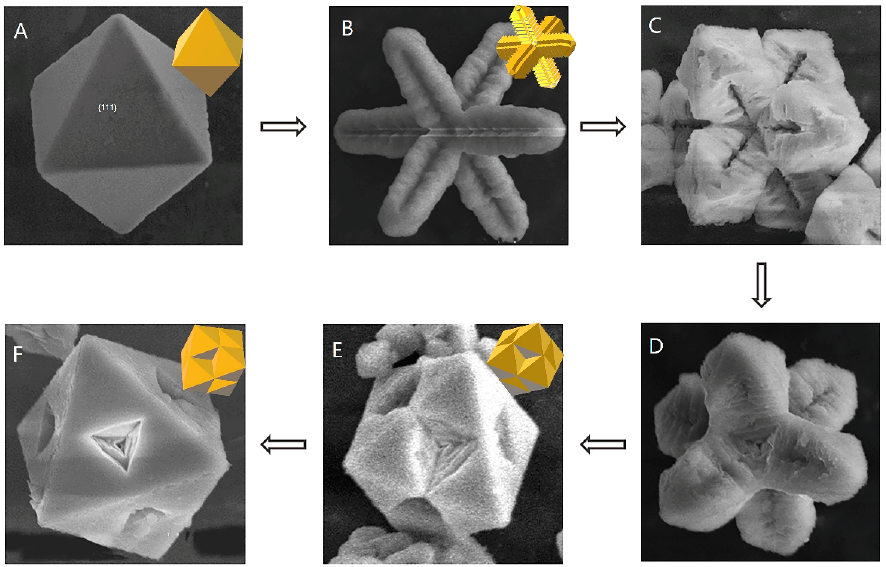
Figure 2. The self-assembly process of Cs 2 SnCl 6 crystal ( A ) octahedron, ( B–D ) Hexapod, ( E–F ) Incomplete octahedron.